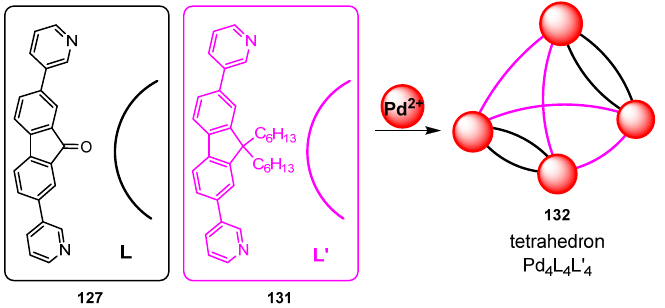
Figure 37. Schematic representation of the selective synthesis and structure of tetrahedral cage Pd 4 L 4 L ′ 4 132 containing two di ff erent types of ligands. Adapted from [114].